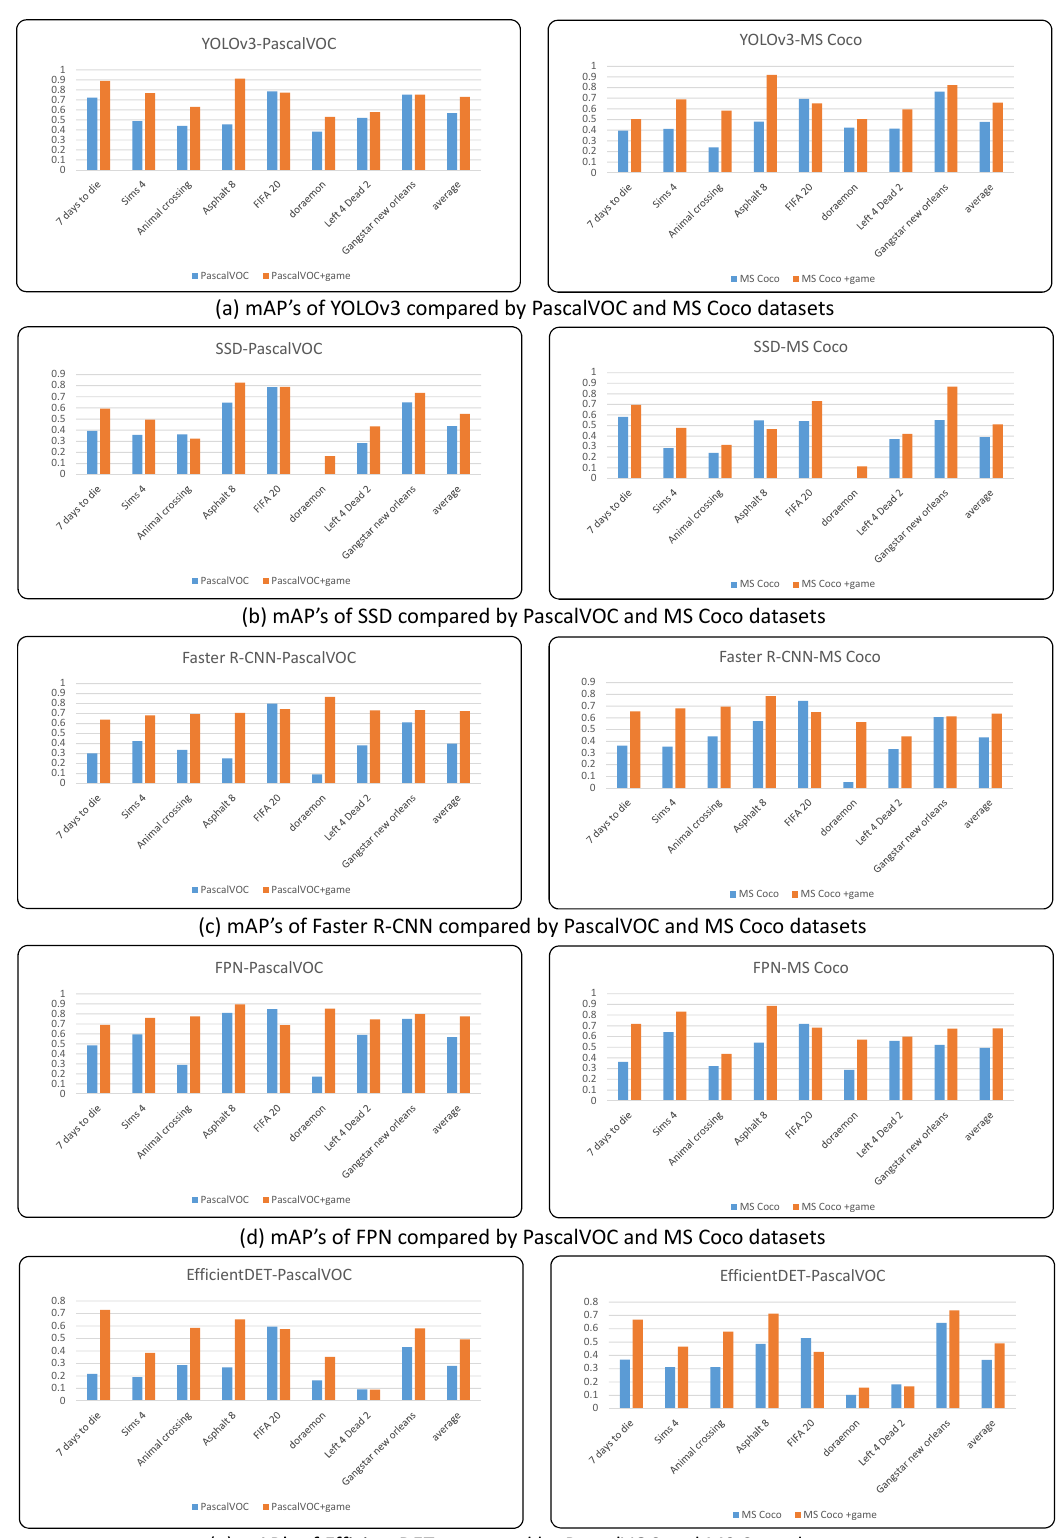
Figure 3. mAPs from five object detection algorithms trained by different datasets are compared. In the left column, blue bars denote mAPs from those models trained using PascalVOC only and red bars are for PascalVOC + game scenes. In the right column, blue bars denote mAPs from those models trained using MS COCO only and red bars are for MS COCO + game